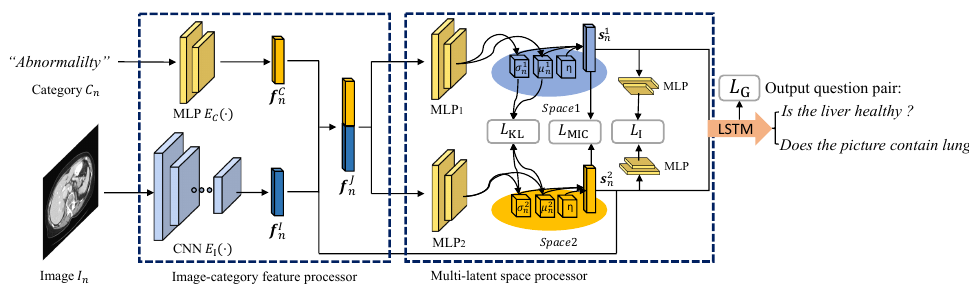
Figure 1. An overview of our medical VQG model with two latent spaces (1 and 2). The proposed model has two novel processors: an image-category feature processor and a multi-latent space processor. The input consists of a medical image and the category of the output question set. The image-category feature processor obtains and combines the features of the image and category. The multi-latent space processor ensures that different spaces contain different information. To make the overview more intuitive, we demonstrate the 2-latent space